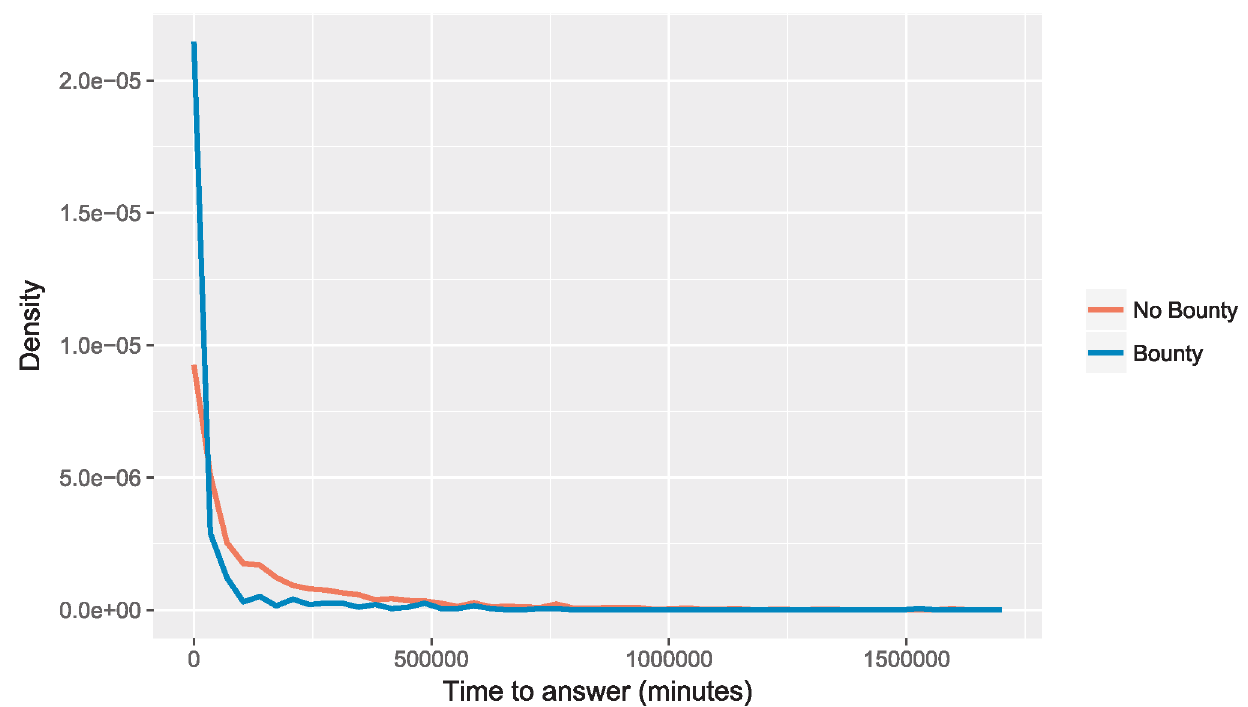
Fig 4. Time to answer density for non-bountied and bountied